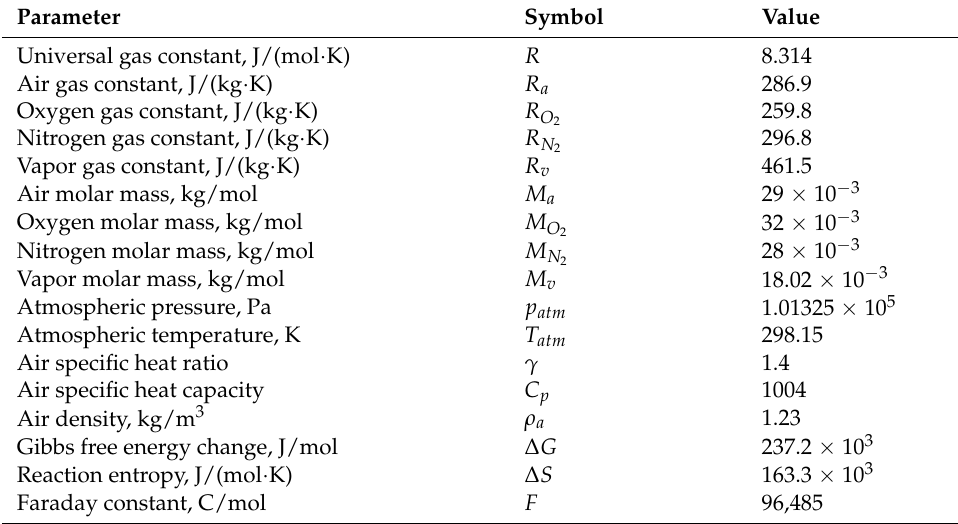
Table 1. Normal parameters of the emulated PEMFC system [22].